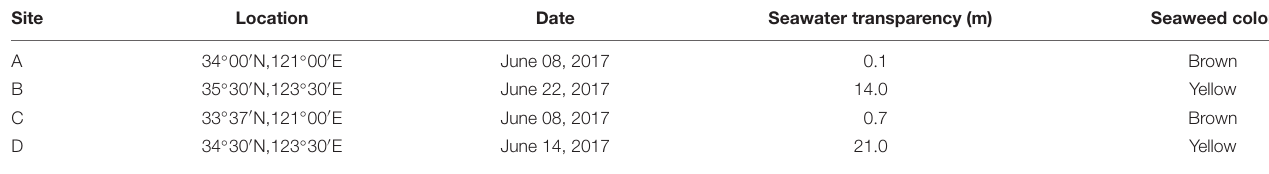
TABLE 1 | Information on sampling sites surveyed in this